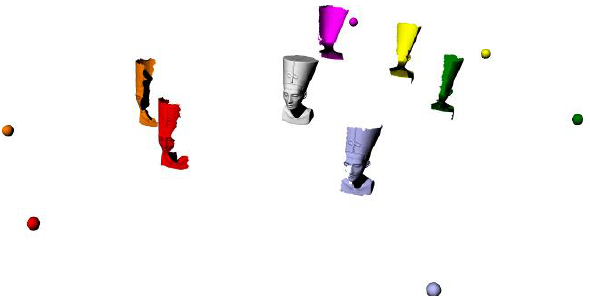
Figure 10. Outcome of the algorithm that considers sufficient overlap and surface